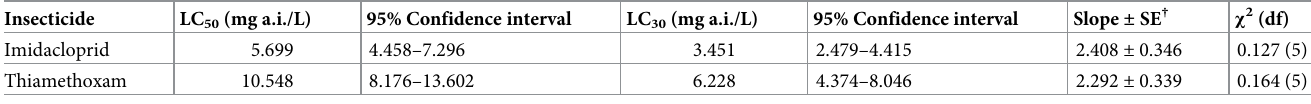
Table 1. Toxicity of imidacloprid and thiamethoxam to the 4 th instar nymphs. Insecticide LC 50 (mg a.i./L)